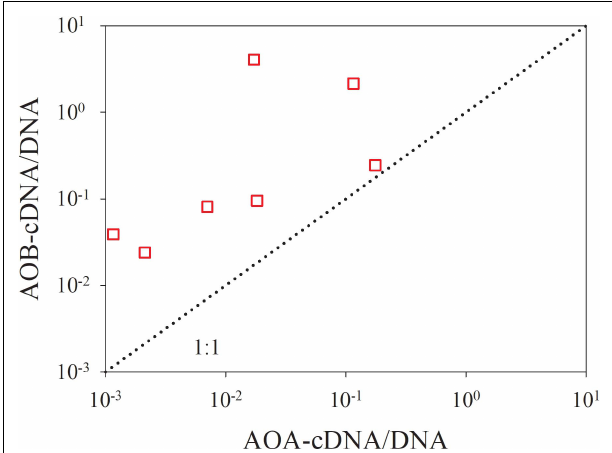
Supplementary Figure 1 | Scatter plots of DO vs. N 2 O (A) and NH + 4 (B) for the surface and bottom waters in the study area. Supplementary Figure 2 | Ratios of β -AOB/AOA for DNA-based amo A gene on the > 3.0 µ m (A) , 0.45–3.0 µ m (B) , and 0.22–0.45 µ m (C) particles, and on all three size fractionated particles (D) . N.D. denotes the β -AOB or AOA undetected on that size fraction.